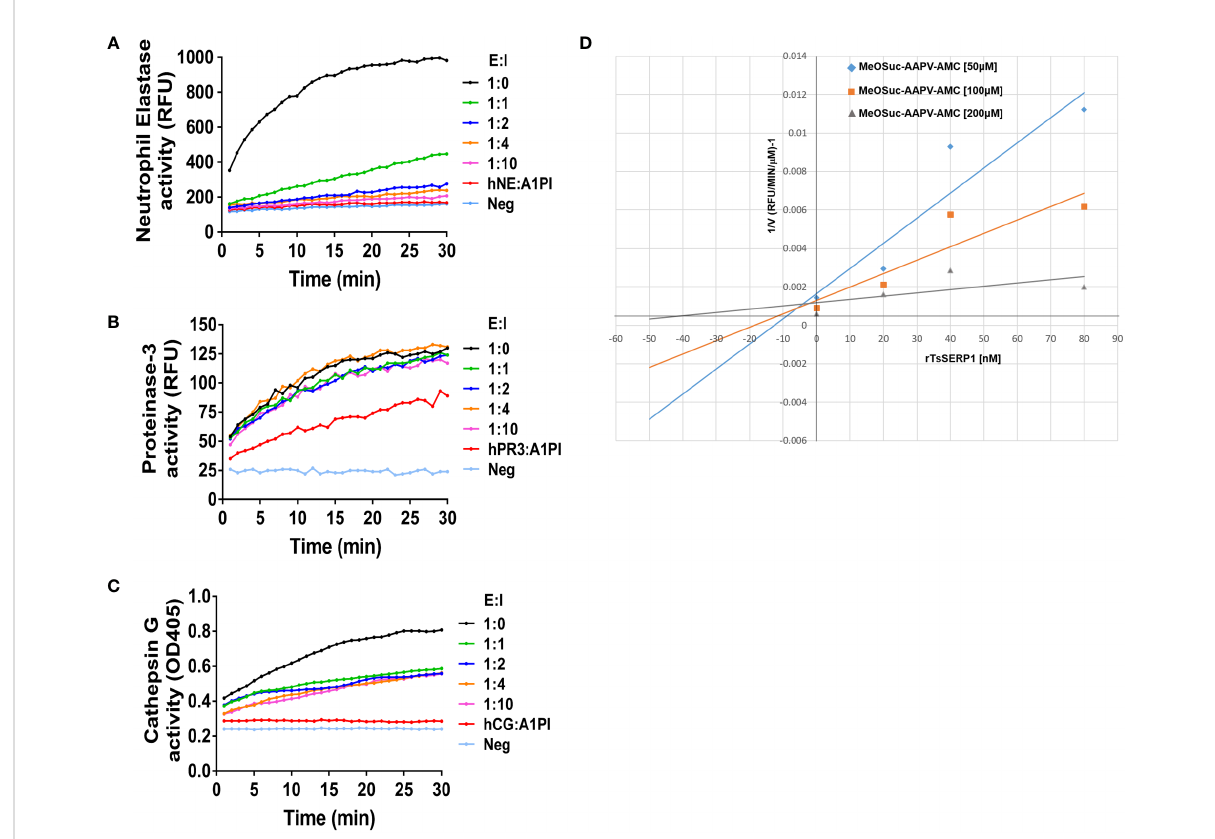
FIGURE 1 The inhibitory activity of rTsSERP1 against human neutrophil serine proteases (hNSPs). The inhibition of rTsSERP1 against NSPs including human neutrophil elastase (hNE) (A) , human proteinase 3 (hPR3) (B) , or human cathepsin G (hCG) (C) was assessed by enzyme inhibitory assays using speci fi c peptide substrates. Each enzyme and rTsSERP1 was incubated at the molar ratios (enzyme: inhibitor) of 1:0, 1:1, 1:2, 1:4 and 1:10. Alpha-1 proteinase inhibitor ( a 1PI) was used as a positive control. The Dixon plot showed the inhibition constant (K i ) of TsSERP1 for hNE (D) . The K i was calculated from the inhibition of hNE by rTsSERP1 (0, 20, 40 and 80 nM) against the fl uorogenic MeOSuc-AAPV-AMC substrate at three different concentrations (50, 100 and 200